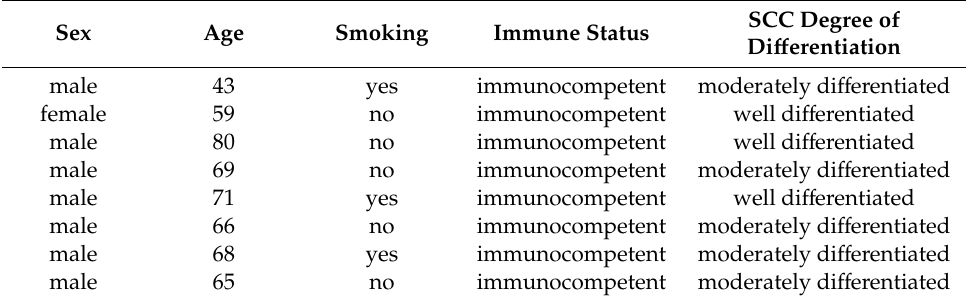
Table 2. Degree of di ff erentiation, immune and smoking status in the SCC